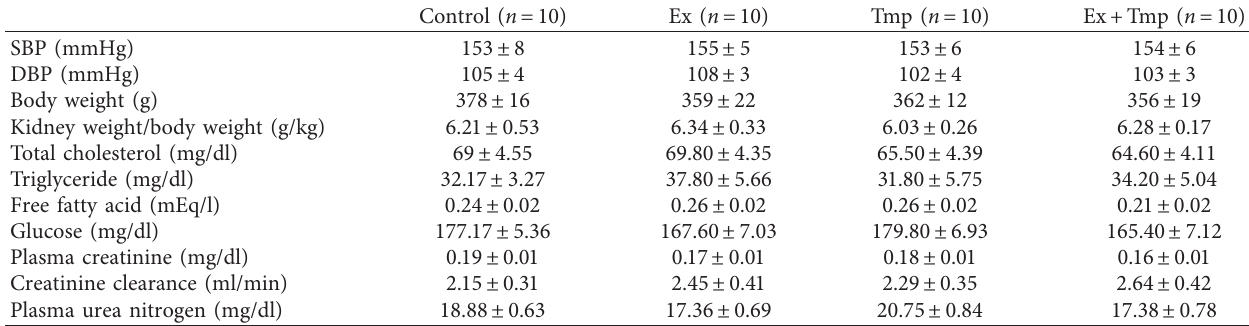
Table 3: Effects of Ex and tempol on the SBP and biochemical variables in WKY.